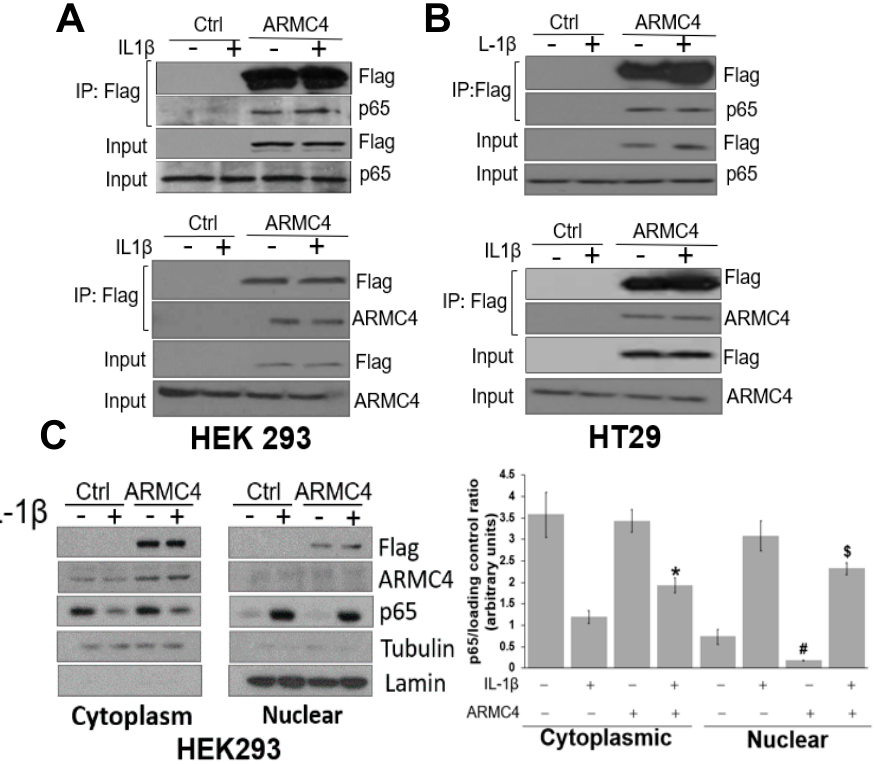
Figure 6. ARMC4 may complex with the p65 subunit of NF- κ B. Co-IP experiments, showing ARMC4 may form a complex with the p65 subunit of NF- κ B (( A , B ) top panels). Co-IP experiments in HEK293 cells (( A ) top panel) or HT29 cells (( B ) top panel) were performed with or without co-expression of Flag-tagged ARMC4. Cells were treated or untreated with IL-1 β for 1 h. Flag-ARMC4 was then pulled down with anti-Flag agarose beads. Samples were then subjected to Western analysis probed with anti-p65 antibody and anti-Flag antibody to detect the co-IP of ARMC4 and p65. For inputs, anti-Flag antibody was used to detect Flag-ARMC4; anti-p65 antibody was used to show the input of total p65. Similarly, co-IP experiments, showing p65 may form a complex with ARMC4 (( A , B ) bottom panels). Co-IP experiments in HEK293 cells (( A ) bottom panel) or HT29 cells (( B )